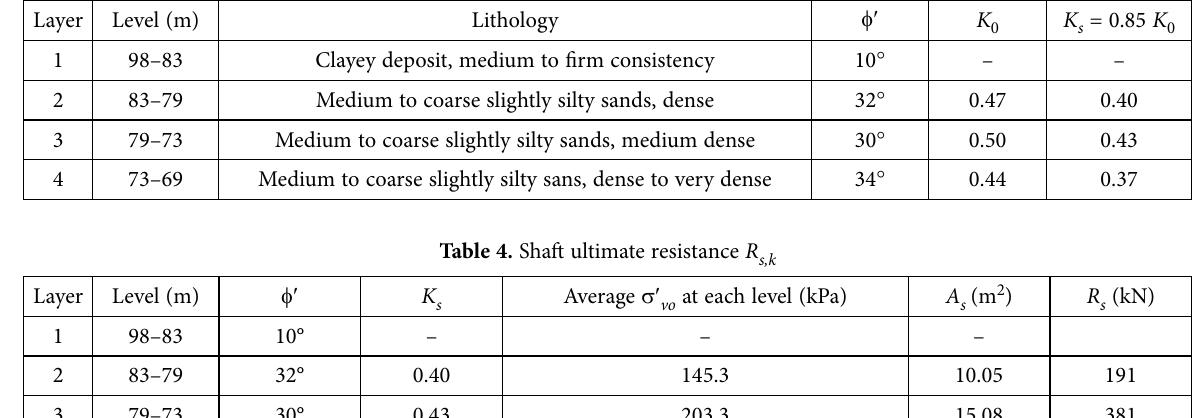
) ( K – the coefficient of earth pressure at rest, K s 0